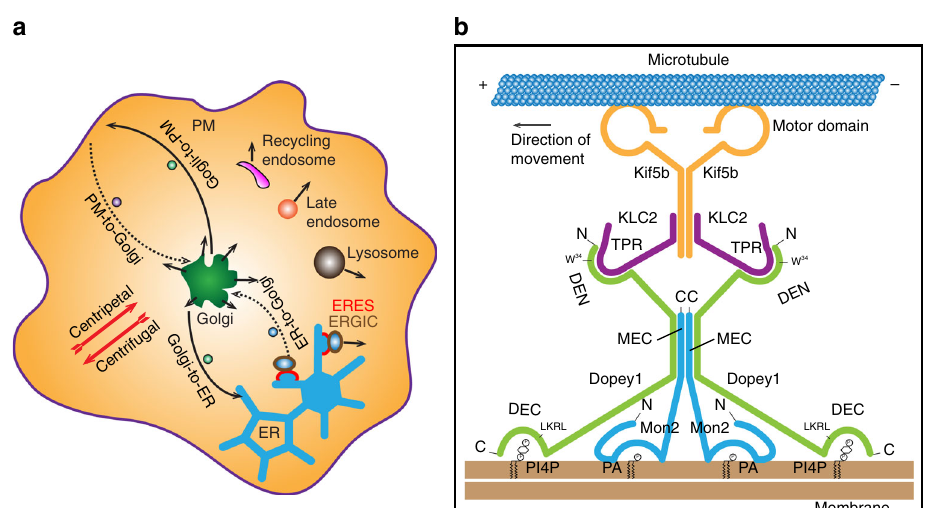
Fig. 9 Schematic summary and model. a The diagram schematically summarizing the cellular function of Dopey1 – Mon2 complex: it promotes the centrifugal (solid line with arrow) and inhibits the centripetal (dotted line with arrow) membrane traf fi cking and organelle positioning. b A schematic model explaining how Dopey1 – Mon2 complex engages the membrane and kinesin-1. Mon2 is a constitutive homodimer and its dimerization is mediated by MEC at its C-terminus. Its N-terminal region interacts with PA (directly or indirectly). In contrast, Dopey1 is a monomer. However, two copies of Dopey1 can simultaneously bind to a Mon2 homodimer, resulting in the formation of a heterotetrameric complex. The interaction between Dopey1 and Mon2 is through Mon2 ’ s MEC and Dopey1 ’ s central region. DEN at the N-terminus of Dopey1 interacts with KLC2 ’ s TPR domain via the WD-motif, while DEC at the C-terminus functions as a PI4P-binding module. In Dopey1 – Mon2 complex, Mon2 seems to dimerize Dopey1 for its high af fi nity binding to